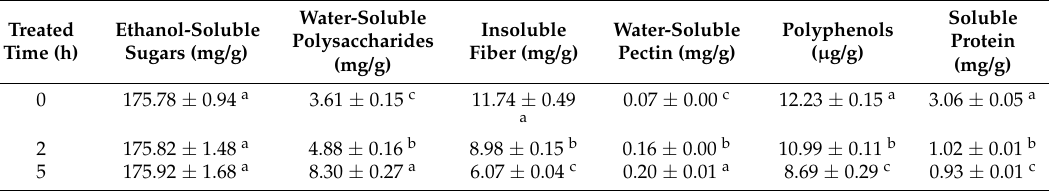
Table 2. Chemical composition of enzyme treated longan juice